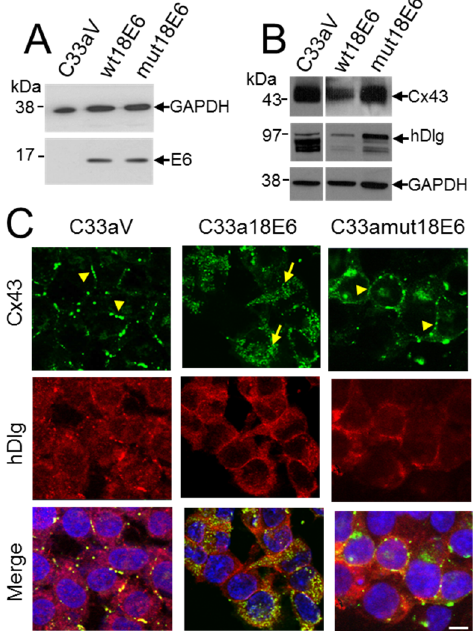
Figure 5. C33a cells expressing a mutant HPV18 E6 that cannot bind hDlg display membrane Cx43. ( A ) Western blot analysis of FLAG E6 expression in C33a cells stably transfected with vector alone (C33aV), vector expressing HPV18E6 (wt18E6) or a mutant HPV18 E6 that does not bind hDlg (mut18E6); ( B ) Western blot analysis of levels of Cx43 and hDlg in C33aV, C33a wt18E6 and C33a mut18E6. GAPDH is used as a loading control for the blots in ( A , B ); ( C ) Confocal immunofluorescence microscopy imaging of Cx43 (green) and hDlg (red) in C33aV cells, C33a18E6 cells and C33amut18E6 cells (cells expressing C-terminal mutated 18E6 that cannot bind hDlg). Membrane gap junction plaques are indicated with arrowheads. The arrow in B indicates cytoplasmic Cx43 staining. Nuclei are stained with DAPI. Bar = 10 μ M.